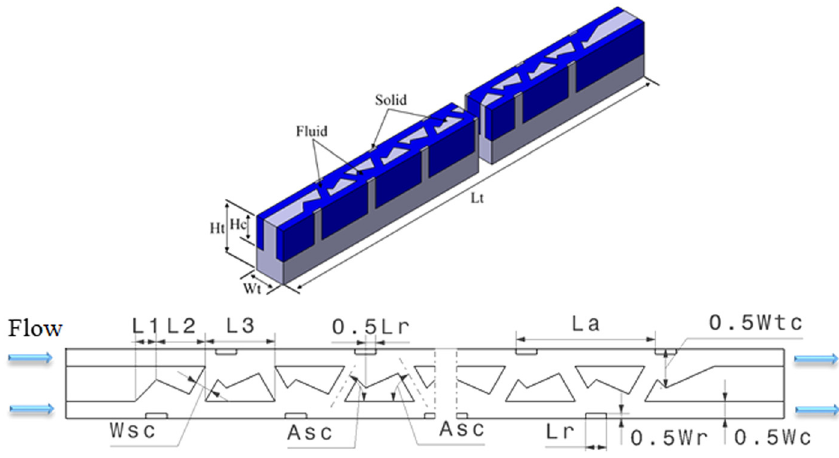
Figure 2: Hybrid MCHS with secondary channel geometry [ 111 ]